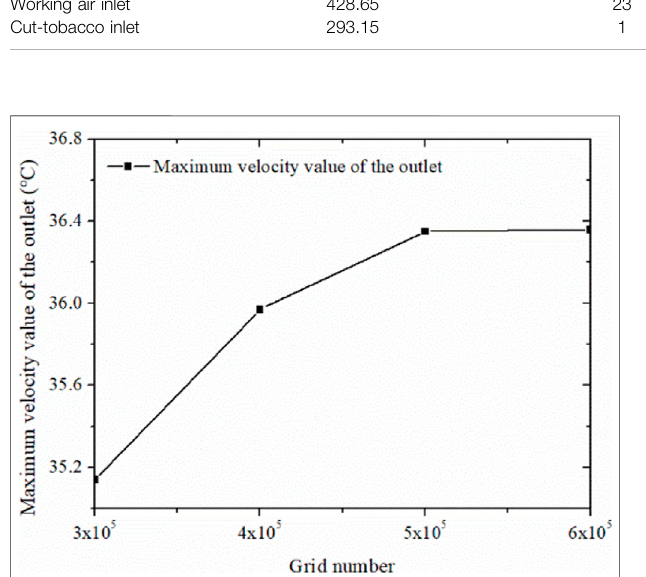
FIGURE 4 | Grid independence